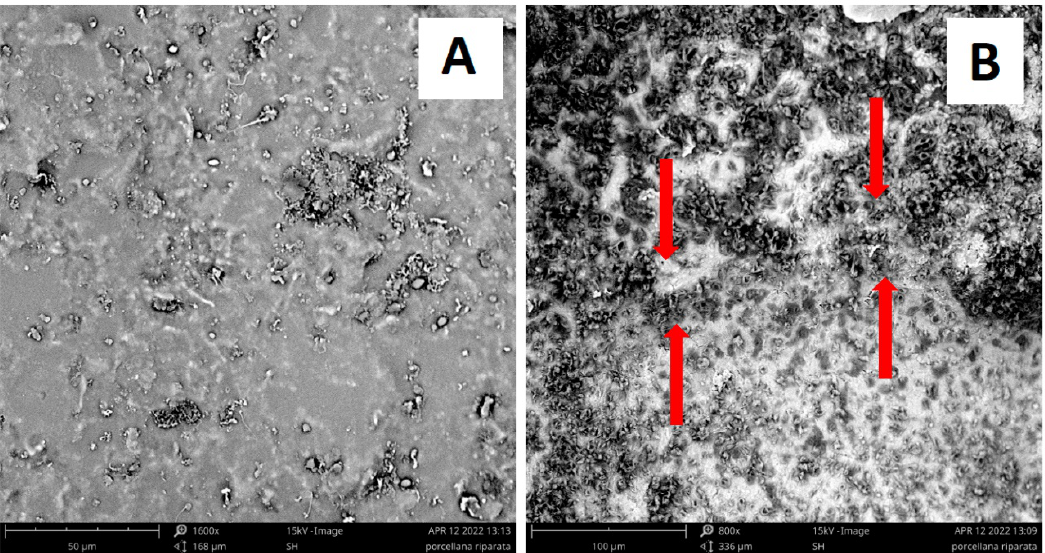
Figure 6. Scanning electron microscope (SEM) micrographs of ( A ) ceramic substrate and ( B ) interface transition zone (indicated by the red arrows) between the ceramic substrate (upper part of the figure) and RP dry -MK geopolymer mortar (low part of the figure).